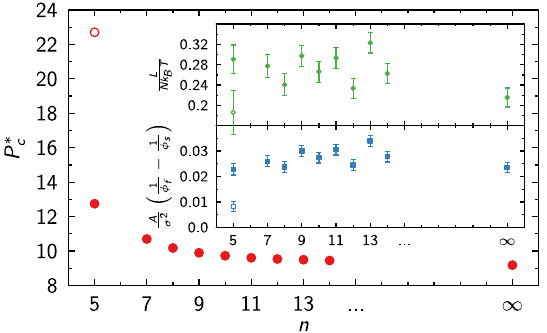
FIG. 8. Latent heat (green diamonds) of the first-order phase transition and the two component factors plotted separately. P (cid:2) (red circles) is the coexistence pressure, and the area difference per particle δ A is shown below (blue squares). Filled symbols are regular polygons, and the open symbols are the fourfold pentille. Error bars are estimated at 0.001 error in the transition densities. Data for disks ( n → ∞ ) are from Ref.